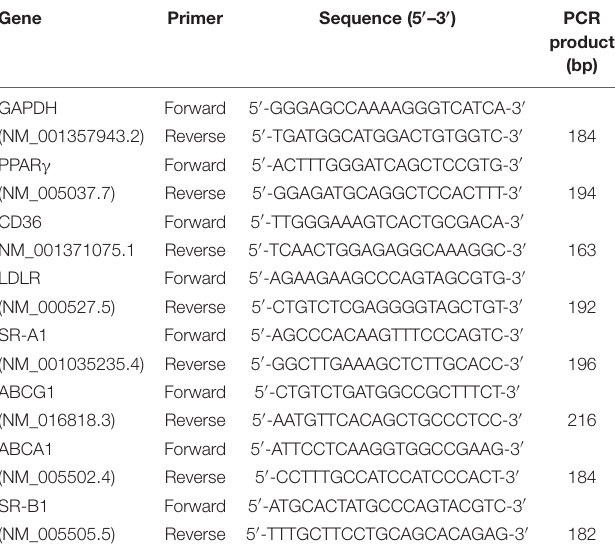
TABLE 1 | The real-time RT-PCR oligonucleotide primers.